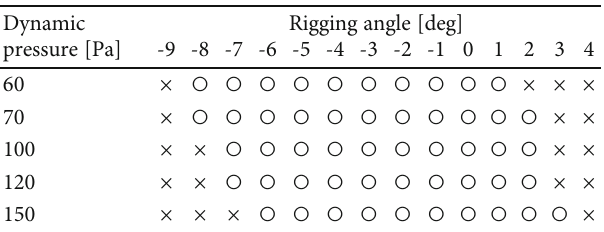
Table 6: Summary of the wind tunnel test results; stable fl ight is ○ and unstable fl ight is ×